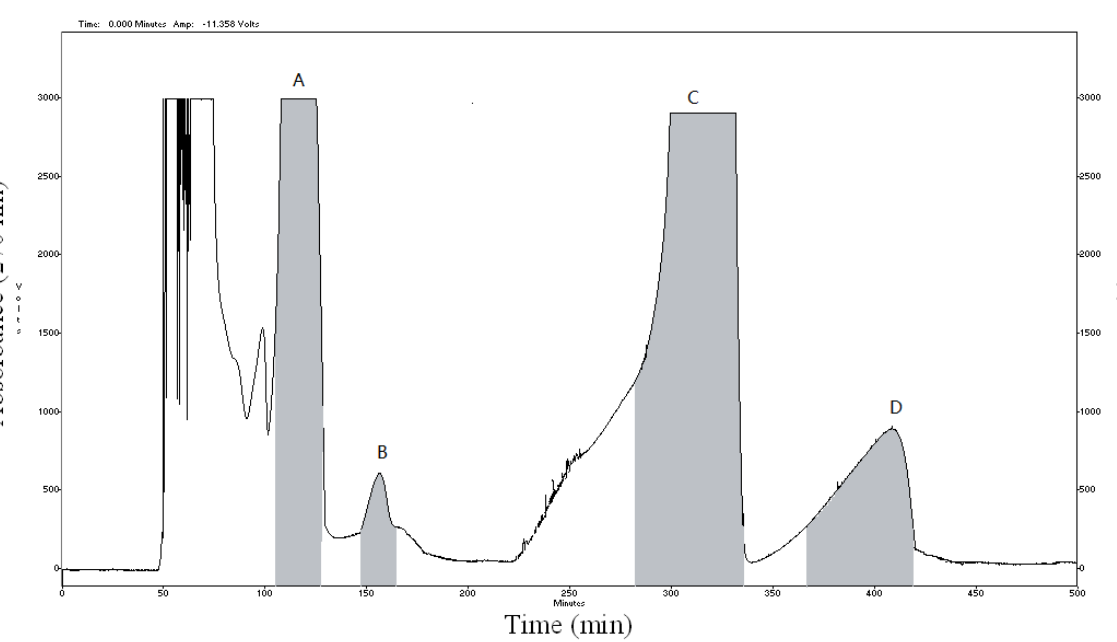
Figure 4. HSCCC chromatogram of crude extract from Lotus Leaf. Conditions: column: multilayer coil of 1.8 mm i.d.; polytetrafluoroethylene tube with a total capacity of 280 mL; rotary speed: 850 rpm; two-phase solvent system: n -hexane-ethyl